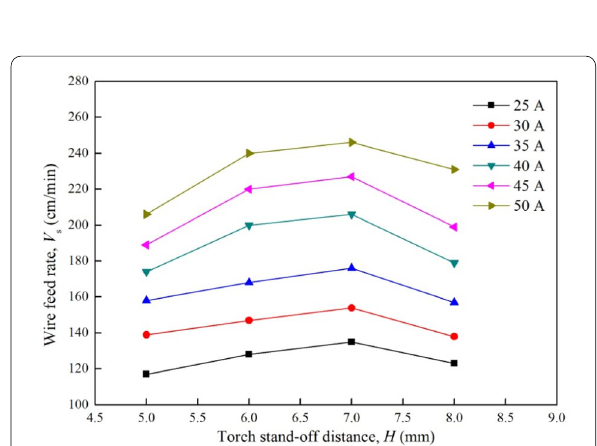
Figure 5 Error between experimentally determined and calculated total voltage values corresponding to different coefficient matrices